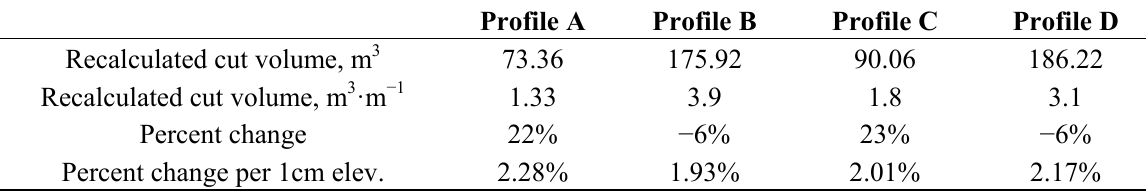
Table 3. Details on the cut volumes after applying the mean error resulting from